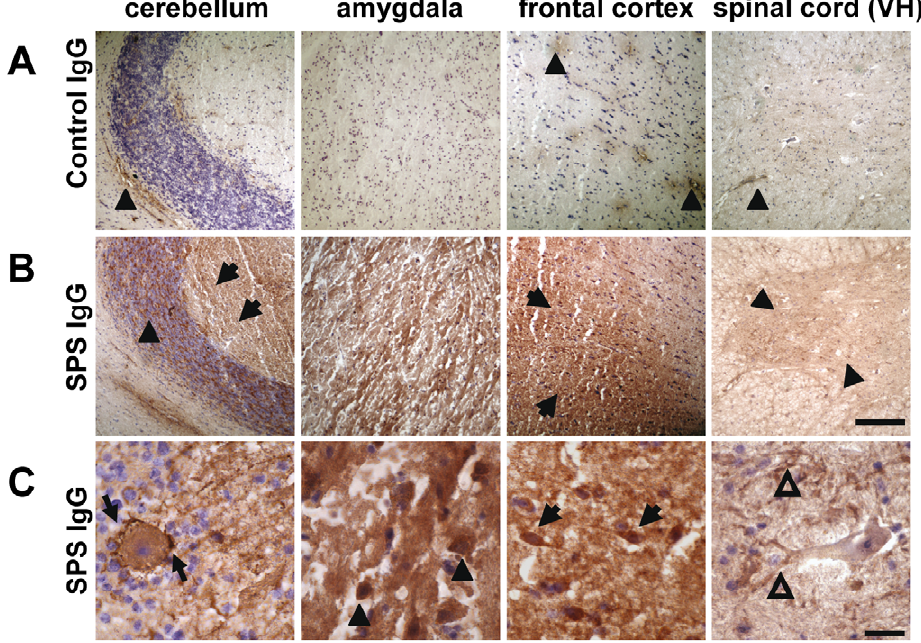
Figure 4. Binding properties of purified SPS - IgG on human CNS tissue. Tissue of normal human cerebellum, amygdala, frontal cortex, and spinal cord was immunoreacted with purified control IgG or IgG preparations containing high titer of GAD 65 antibodies (scale bar 200 m m). Incubation with control IgG (A) resulted in unspecific perivascular staining (arrowheads), whereas SPS IgG (B) gave intense labeling of the molecular (arrows) and granular layer (arrowheads) in the cerebellum, of the amygdala core region, and the grey matter of the frontal cortex (arrows). SPS IgG immunoreactivity in the ventral horn (VH) of the spinal cord (arrowheads) was less pronounced as compared to the highly immunoreactive brain regions, particularly the amygdala and frontal cortex. (C) Higher magnification revealed (1) strongly positive staining of GABAergic basket cell fibers around Purkinje cells in the cerebellum (thin arrows), (2) a very intense staining of the densely packed reticular network in the amygdala and some small sized interneurons (arrowheads), (3) positive immunoreactivity of single interneurons (thick arrows) in the deeper layers of the frontal cortex, and (4) less strong staining of perineuronal dendrites and proximal dendrites of a motor neuron (open arrowheads) in the ventral horn of the spinal cord (scale bar: 25 m